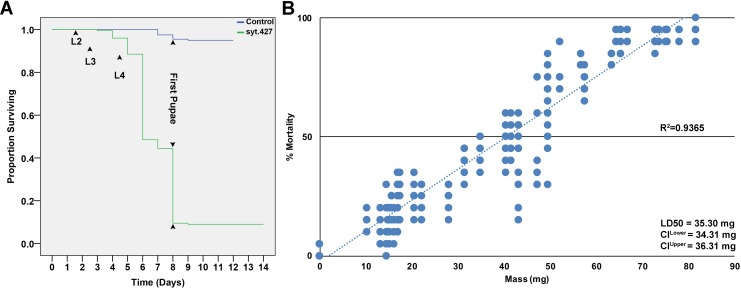
Assessment of yeast interfering RNA larvicide syt.427 activity in A. aegypti.A. Consumption of inactivated dried yeast interfering RNA syt.427 larvicide tablets induced larval mortality in the L4 larval or pupal stages (days 4–8; compare to larvae fed with control yeast interfering RNA that survived and pupariated). B. Dose-response curves depicting the mass of syt.427 vs. the percentage of A. aegypti larval mortality are shown. LD50 values for syt.427 with upper and lower confidence limits (CL) are indicated. Regression analysis demonstrated that the dose-response data were linearly correlated (R2 = 0.9365). Additional details regarding calculation of lethal doses are provided in the methods section.